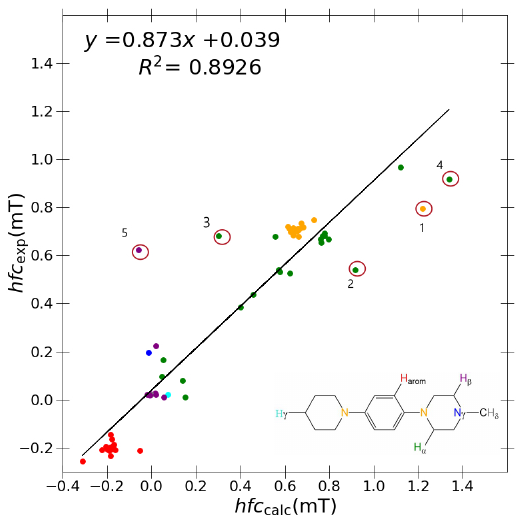
Figure3. Correlationbetweenexperimentalhyperfinecouplingconstantsandcalculatedconstants usingPBE0/6-31G(d,p)-J/PCMmodel. OutliersmarkedwithcirclesareDMeAzirA-1) a N 2) a H CH 3) 3 andDMeAzetA-4) a H CH 5) a H CH . Thecolorcodingoftheresultscorrespondtothegeneral a H CH 2 2 α 2 β N,N,N’,N’ -tetrasubstituted p -phenylenediamineshownintheinset: Orange( ): a N ;Blue( ): a N γ ;Red ( ): a H arom ;Green( ): a H CH ;Purple( ): a H CH ;Cyan( ): a H CH ;Grey( ): a H CH 2 α 2 γ 2 β 3